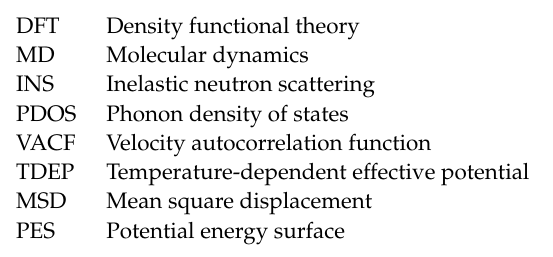
Figure S3: Unnormalized probability distributions of H atom in ZrH 2 in (112) plane along x